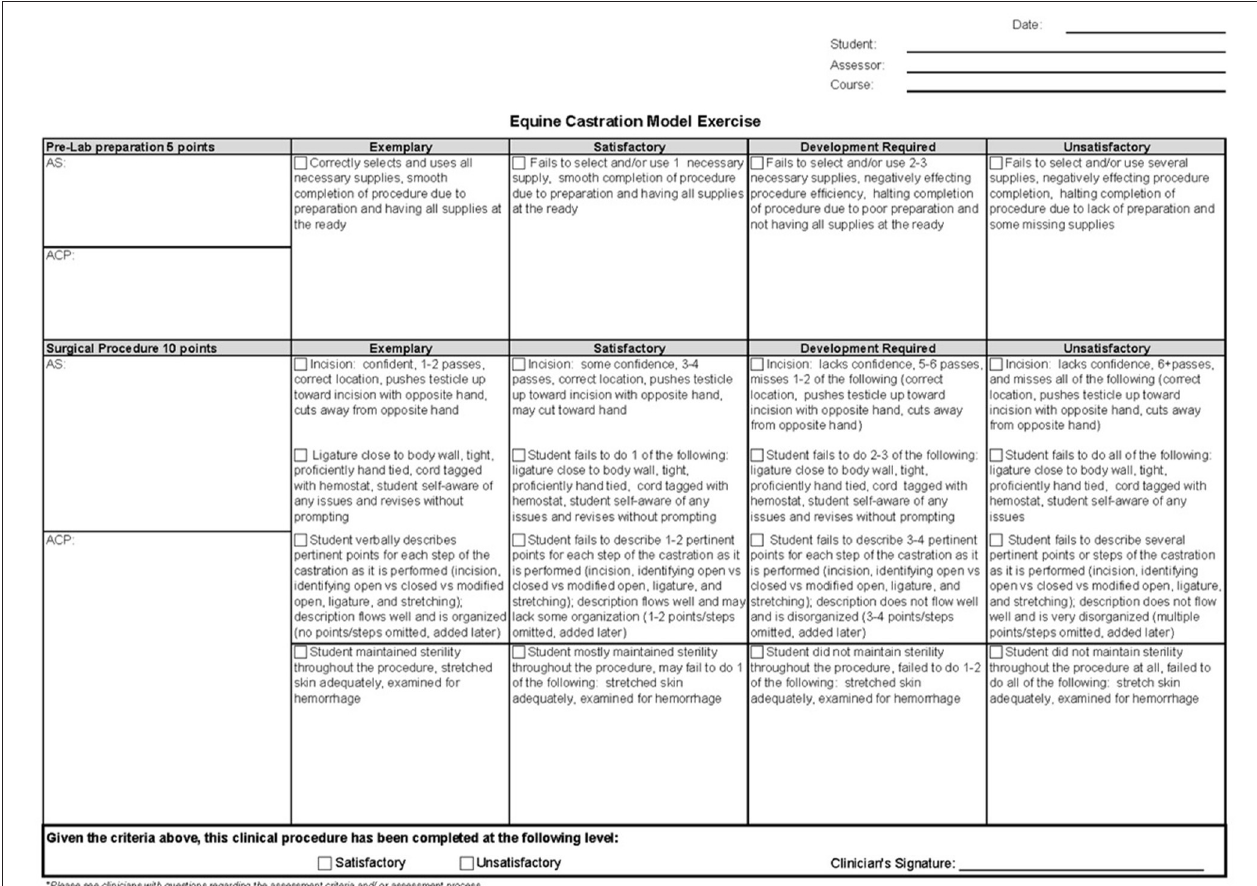
FIGURE 3 | Low-fidelity castration model rubric. Exemplary = 3 points, Satisfactory = 2 point, Development required = 1 point, Unsatisfactory = 0 points. AS, areas of strength; ACR, areas for concentrated